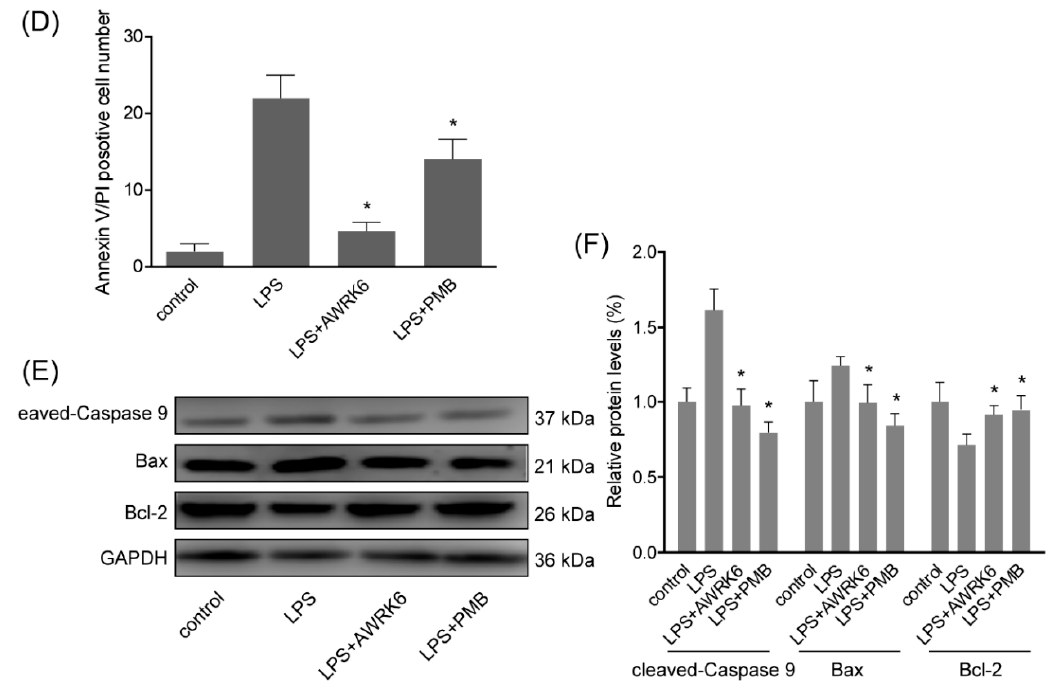
Figure 3. AWRK6 inhibited LPS-induced liver cell apoptosis in HepG2 cells. ( A ) The viabilities of HepG2 liver cells treated with LPS (40 μ g/mL) with/without AWRK6 for 24 h, examined by MTT assay. ( B ) The cells treated with LPS and AWRK6 (200 μ g/mL) were observed under phase contrast microscope. ( C ) The cell apoptosis was detected by Annexin V-FITC/PI staining followed by fluorescence microscopy. ( D ) The apoptotic cell number in the results of Annexin V-FITC/PI staining was analyzed by ImageJ. ( E ) The protein levels of cleaved-caspase 9, BAX and Bcl-2 were analyzed by western blotting. ( F ) The results of western blotting were quantified using ImageJ. Bar indicates 100 μ m. * p < 0.05 compared with the LPS groups.